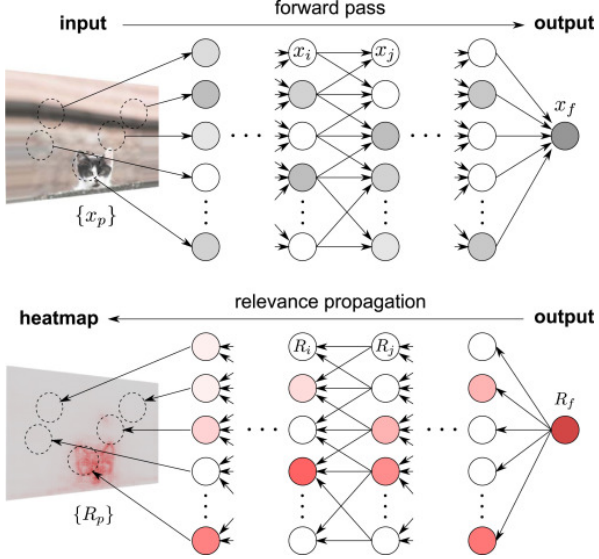
Figure 7. Layerwise Relevance Propagation (LRP) [53] is a gradient method suffering from the shattered gradients problem. The idea behind it is a decomposition of the prediction function as a sum of layerwise relevance values. When the LRP is applied to deep ReLU networks, the LRP can be understood as a deep Taylor decomposition of the